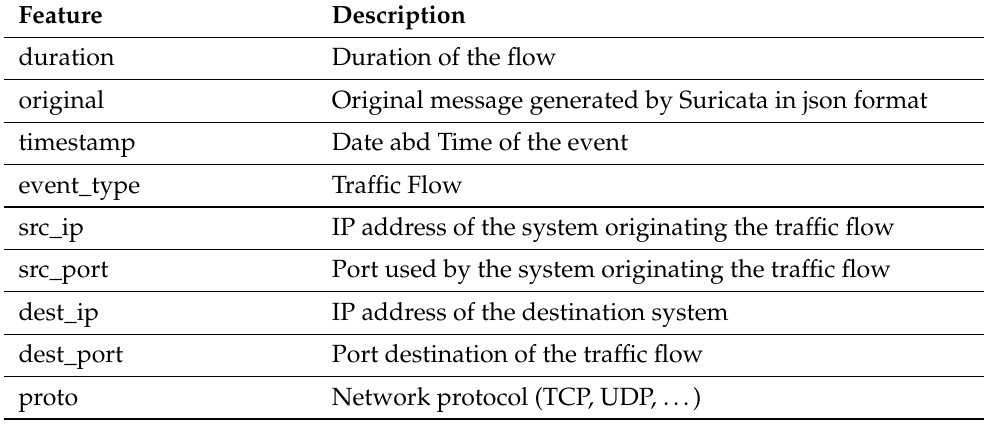
Table 5. NID-related attributes in CSV